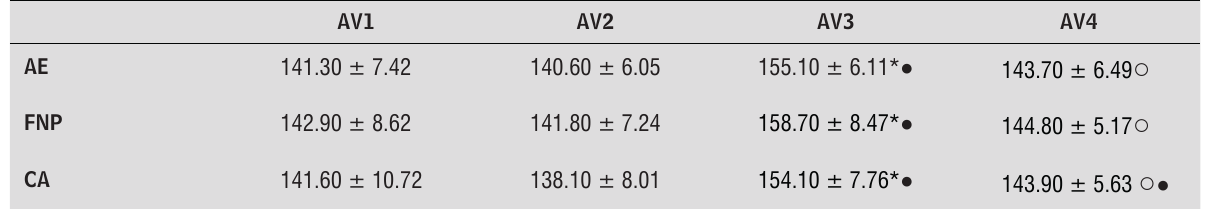
Table 1 - Assessment results obtaind with the goniometric board in degrees, values presented as averages and standard deviation for different groups in different time points (EV)